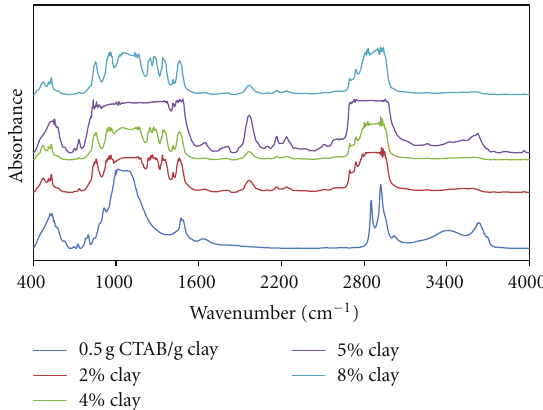
Figure 7: FTIR spectra of produced organoclays at various CTAB- clay ratios.